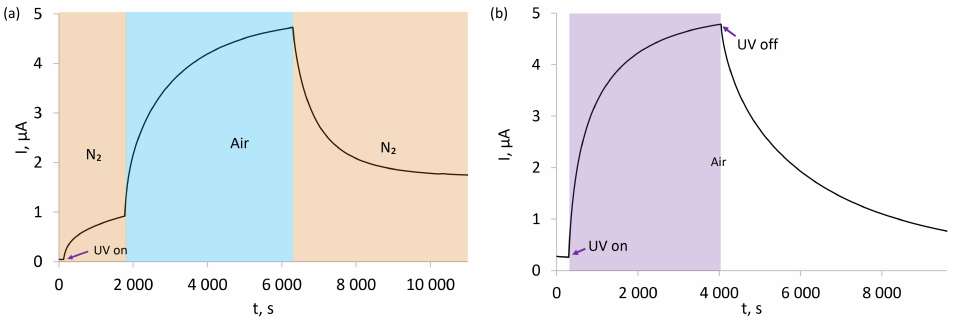
Figure 9. ( a ) Effect of UV activation in nitrogen and effect of exposure to air in UV after N 2 for SilPEG; ( b ) effect of UV activation in air and relaxation after UV in air for SilPEG.